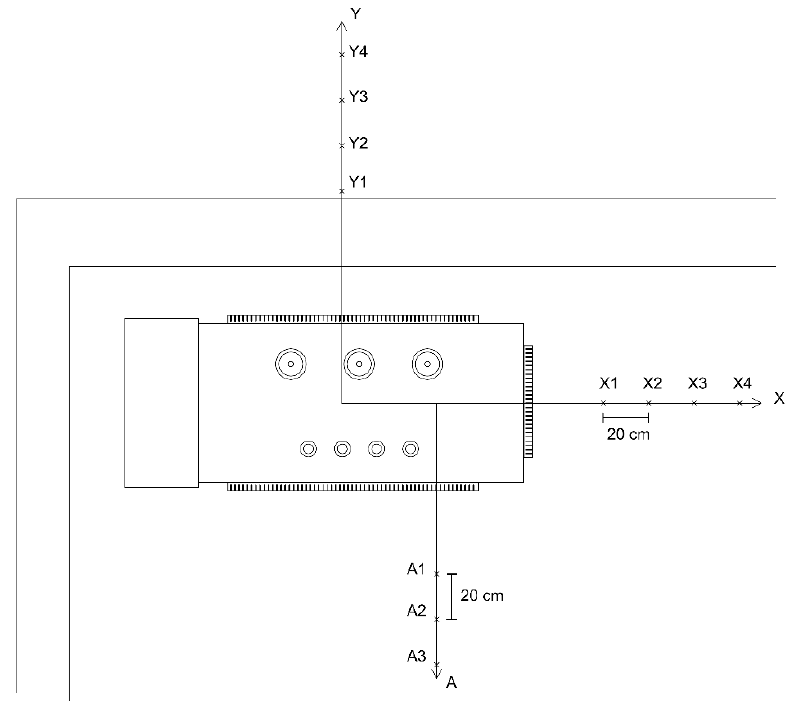
Figure 6. Diagram of the studied distributed transformer and the points where the MFD has been measured.